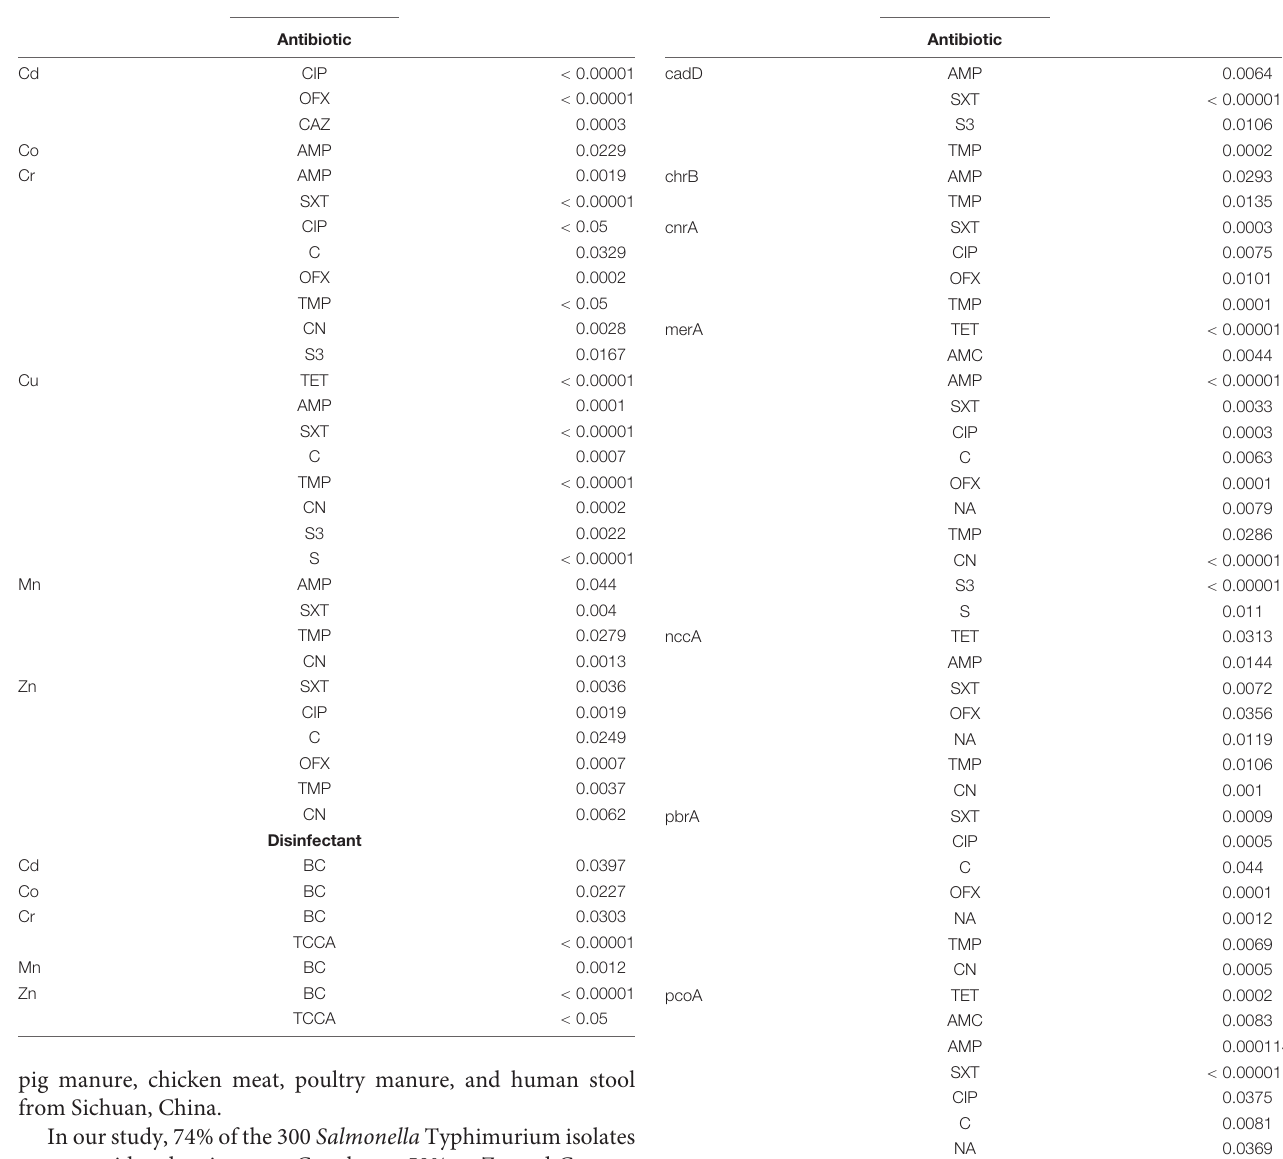
TABLE 5 | The association of metal resistances with antibiotic and disinfectant resistance in Salmonella Typhimurium. Metal Antibiotic/Disinfectant